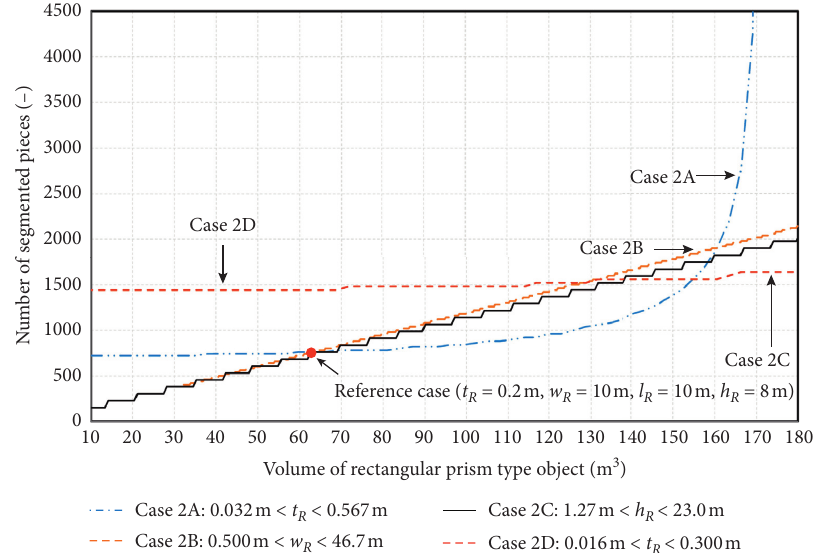
Figure 14: Number of segmented pieces along with variation of the volume of rectangular prism-type object from 10 m 3 by changing one parameter only for each case (i.e., thickness in Case 2A, length or width in Case 2B, and height of object in Case 2C). Case 2D represents a priori segmentation in half of the same object assumed in Case 2A and application of generalized segmentation